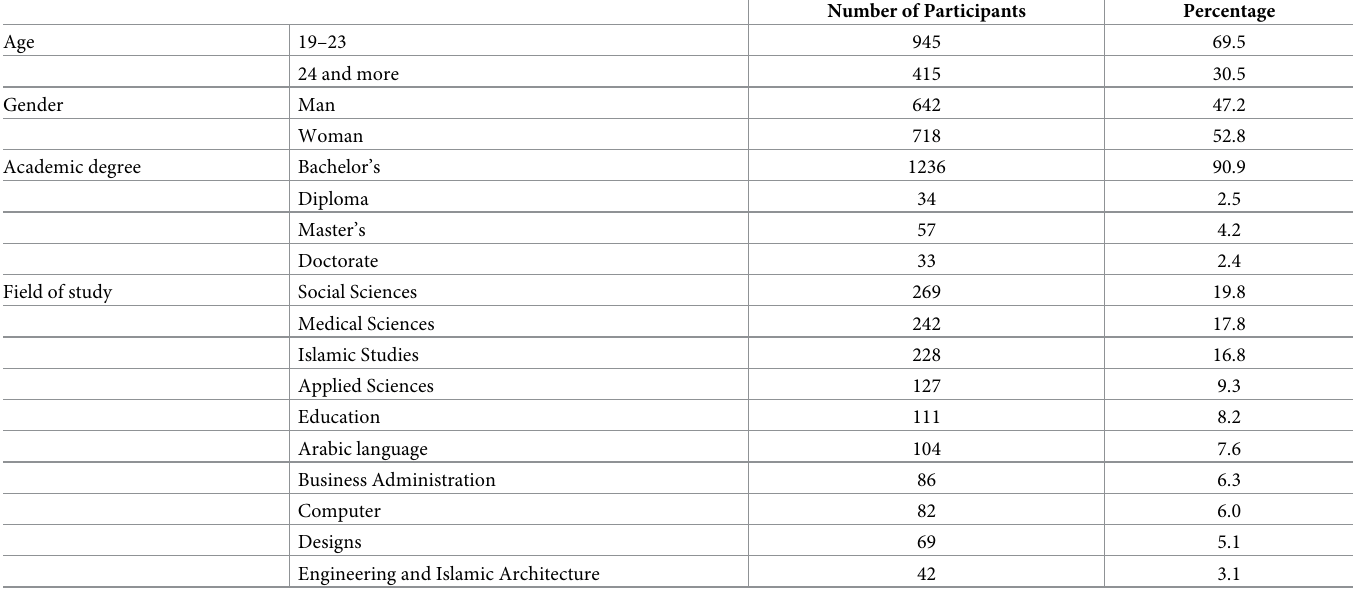
Table 1. Demographic information of the